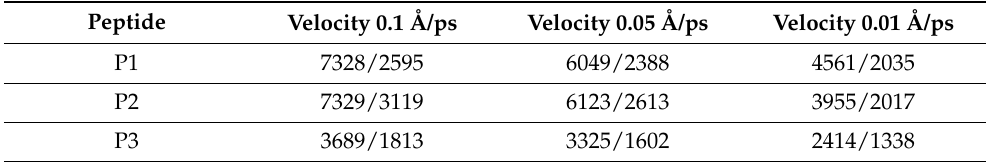
Figure 5. Compactization of P2 peptide (EMEVVVLNID) during relaxation: ( A ) the peptide after construction; ( B ) the peptide after relaxation in an aqueous environment after 1 ns. Table 2. The values of the maximum peak force averaged over 8 realizations when the peptide is pulled over the center of mass/pulled by the terminal